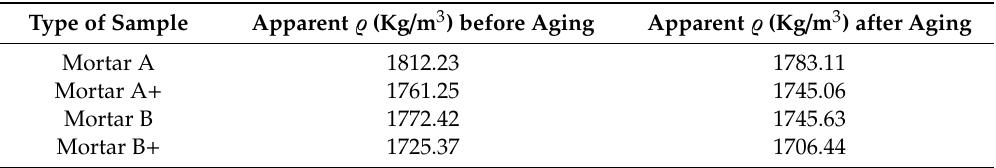
Table 3. Apparent density before and after